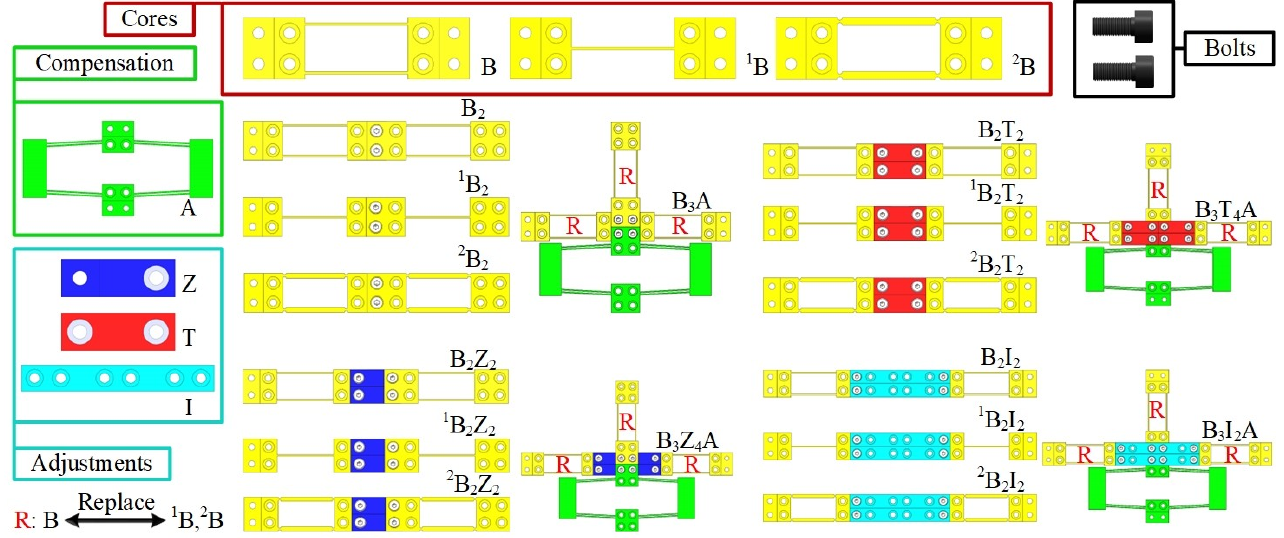
Figure 9. Assembly of two-DOF MPSs based on basic blocks.